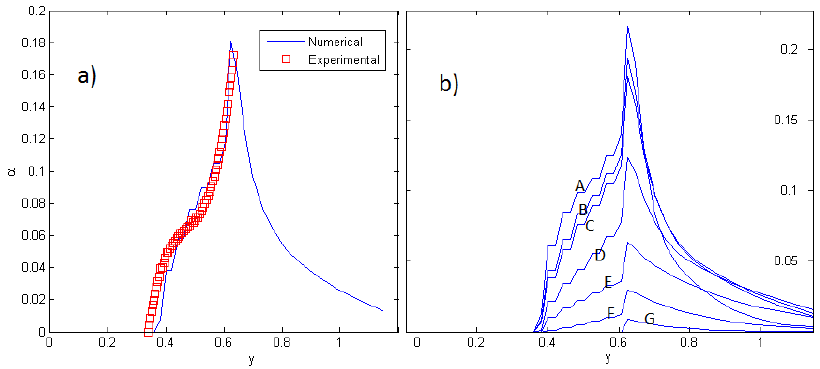
Figure 3. Void fraction ( a ) comparison of the current numerical study with the experiment [29]; ( b ) effects of the electric field and the magnetic field (see Table